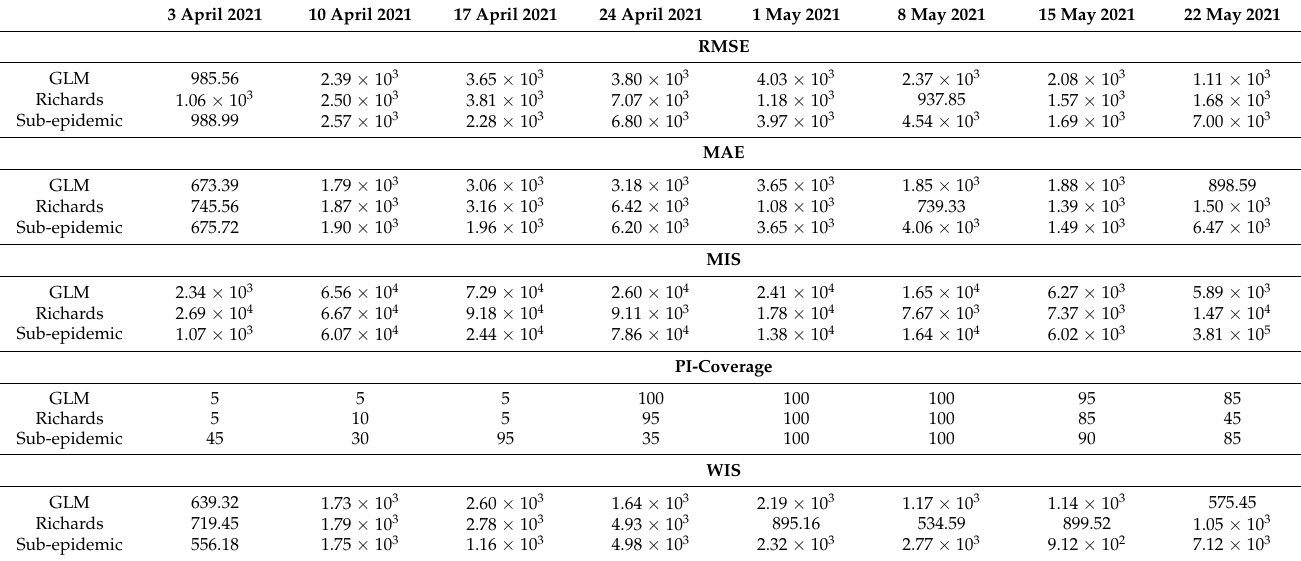
Table 3. Comparison of performance metric during 20-days ahead